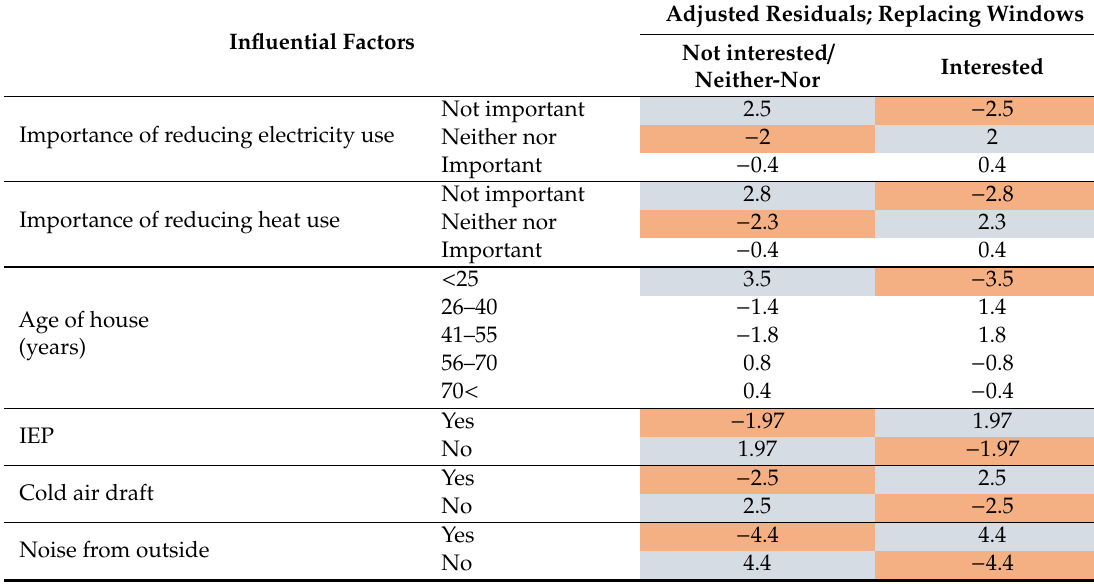
Table A1. Post-hoc analyses of influential factors on homeowners’ interest to replace windows.